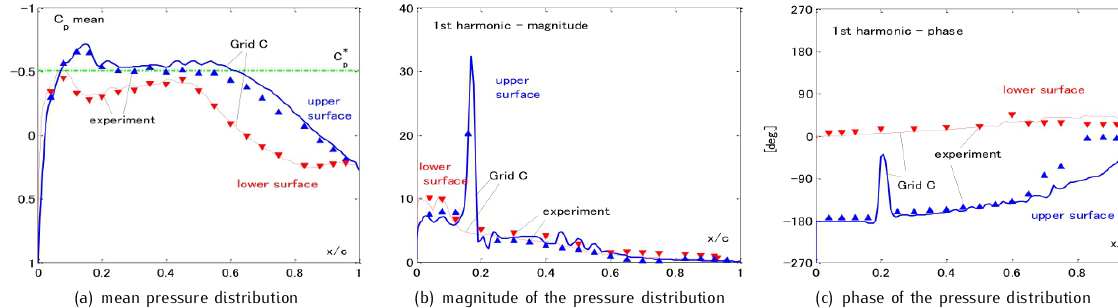
Figure 14. Unsteady pressure distribution (#09242).